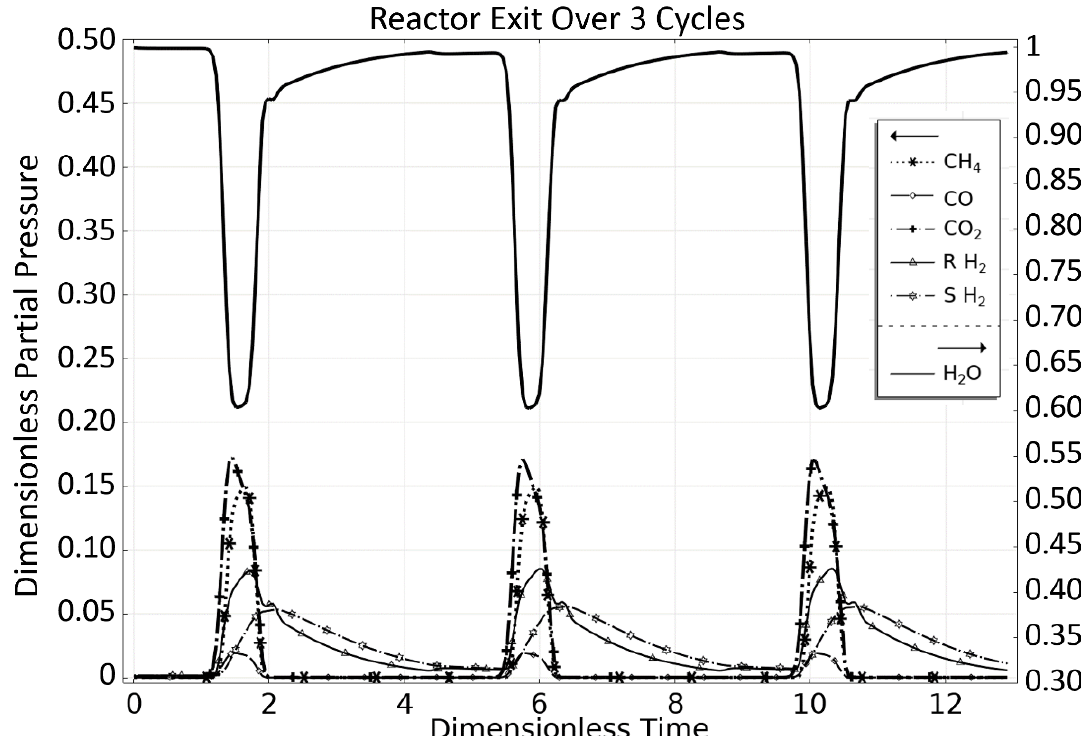
Figure 4. Dimensionless time evolution of species’ dimensionless partial pressure at reactor outlet over 3 cycles of operation for Da = 2, Θ = 10.